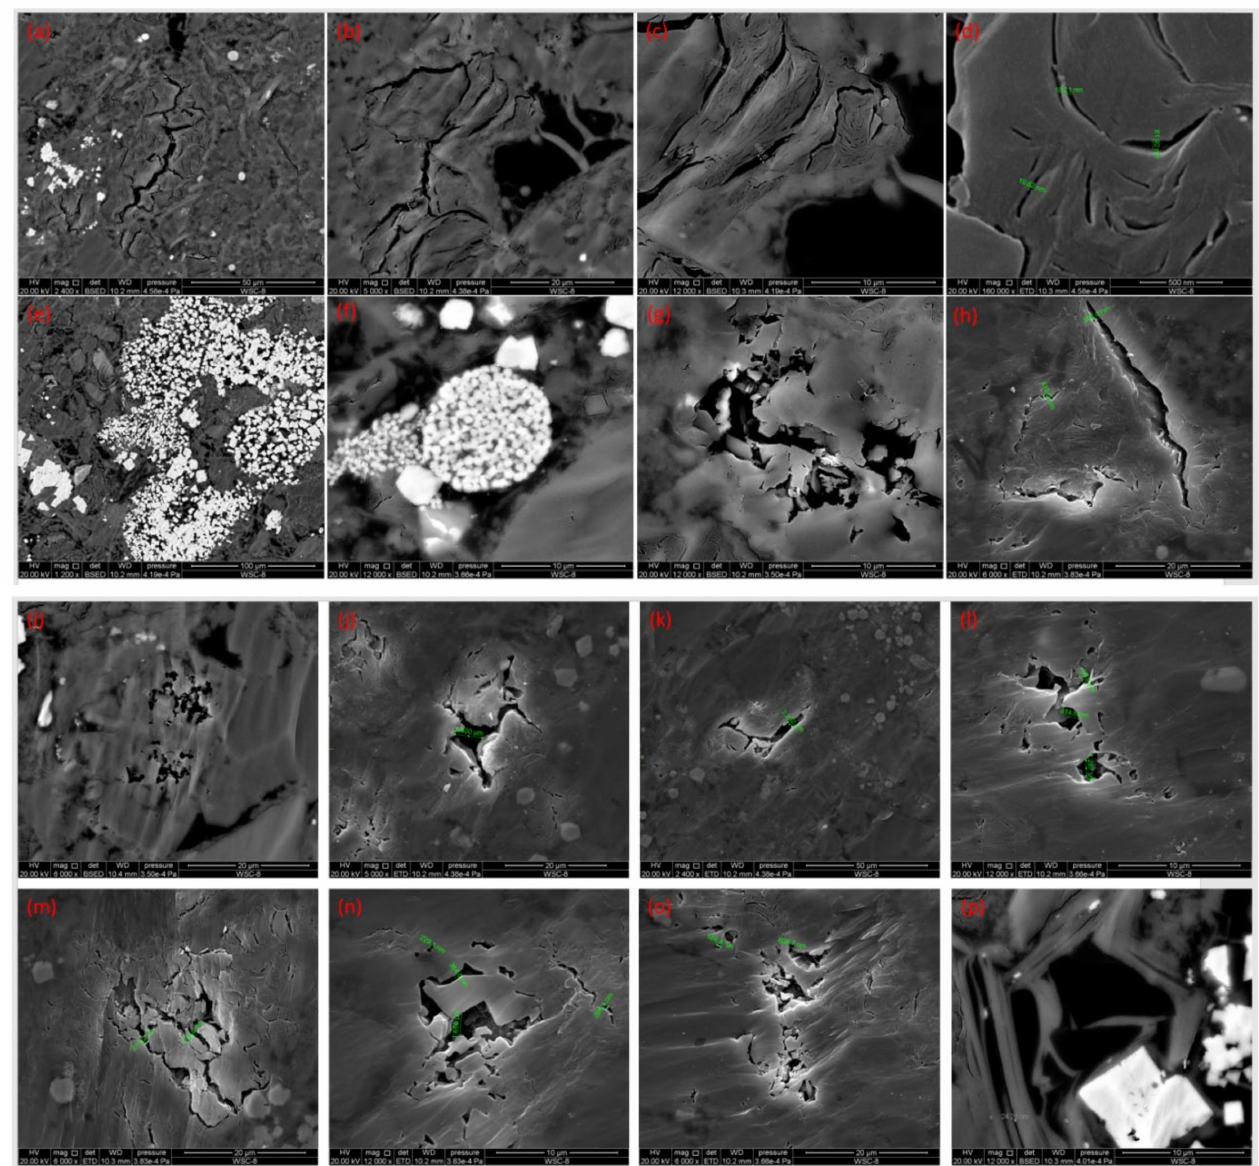
Figure 2. Development characteristics of nanometer pores in black shale of the Niutitang formation in Wenshuicun, Guizhou. ( a – d )—clay mineral shrinkage crack; ( e )—filling with organic matter in pyrite; ( f )—framboidal pyrite intergranular pore; ( g , i – o )—clay mineral dissolution pore; ( h )—tectonic fractures; ( p )—overpressure